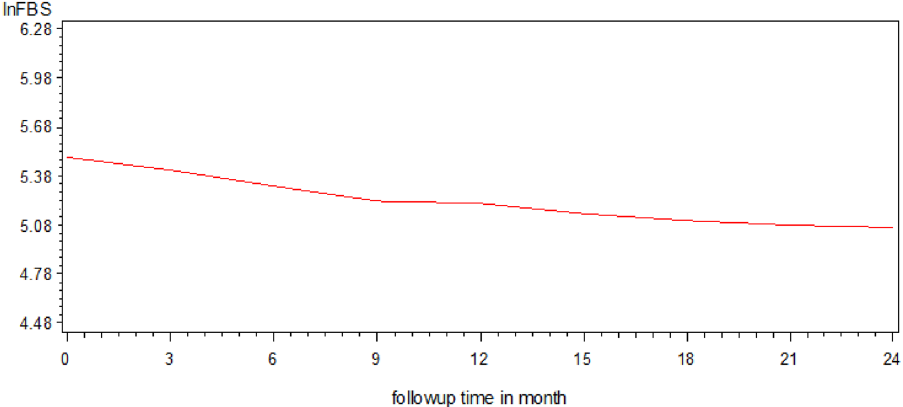
Figure 4. The overall mean profiles of T1DM patients over follow-up time.